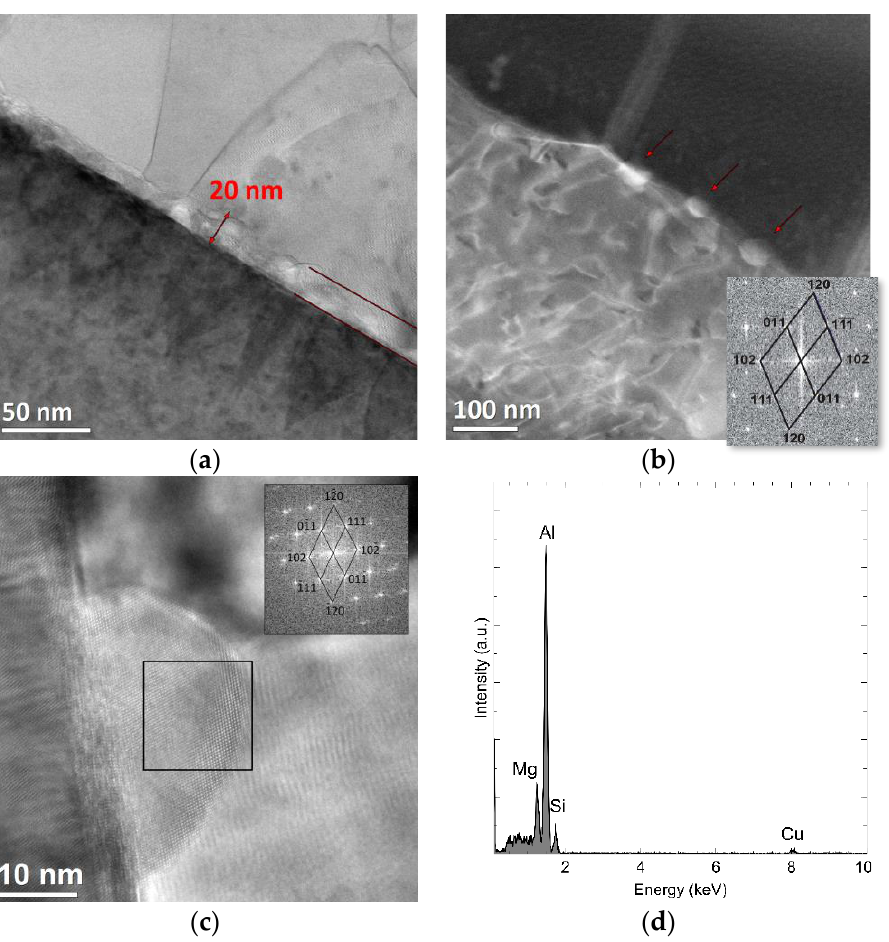
Figure 12. Transition zone between metal and ceramic phase with visible particles. ( a ) STEM-BF image, ( b ) STEM-HAADF image, ( c ) HR TEM image of Al0.45Mg1.5Si precipitation in [211] zone axis with Fourier transform FFT calculated for the marked area, and ( d ) results of the chemical composition analysis obtained using X-ray dispersion spectroscopy.